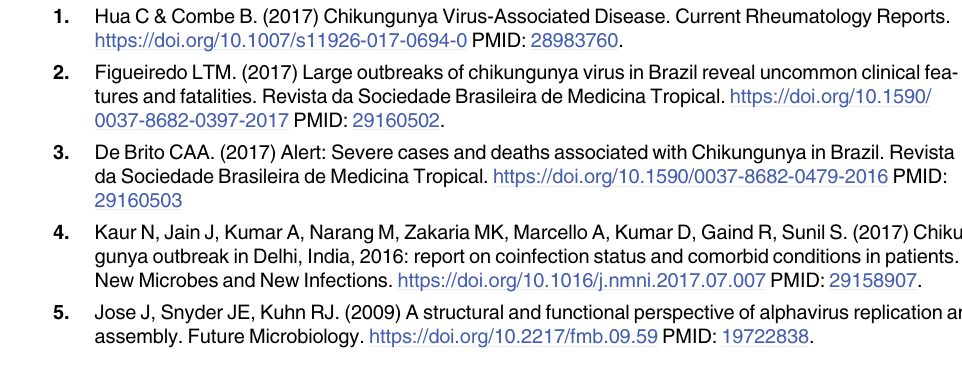
S3 Fig. DSSP analysis of 6K hexamer in membrane showing the evolution of the protein secondary structure during the simulation time